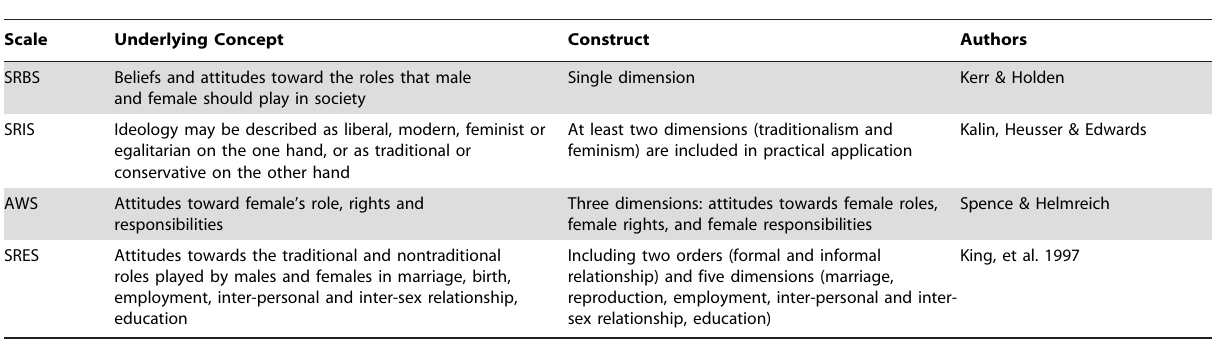
Table 1. Gender Role Ideology from Various